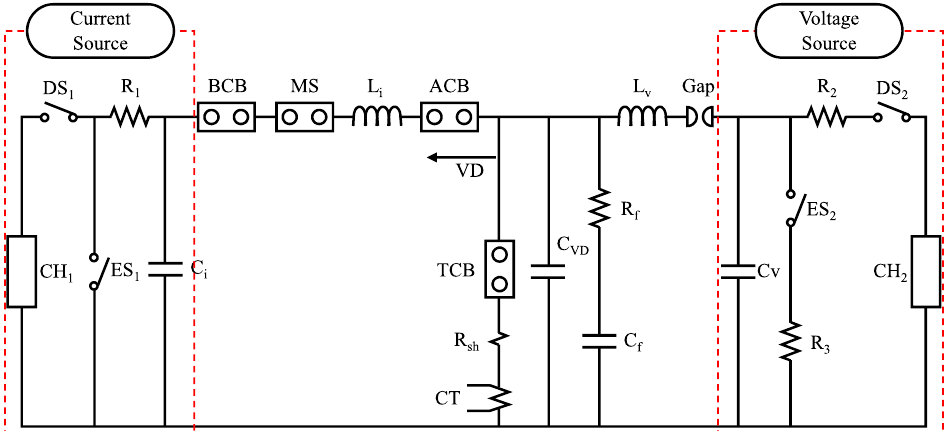
Figure 1. Synthetic test circuit for